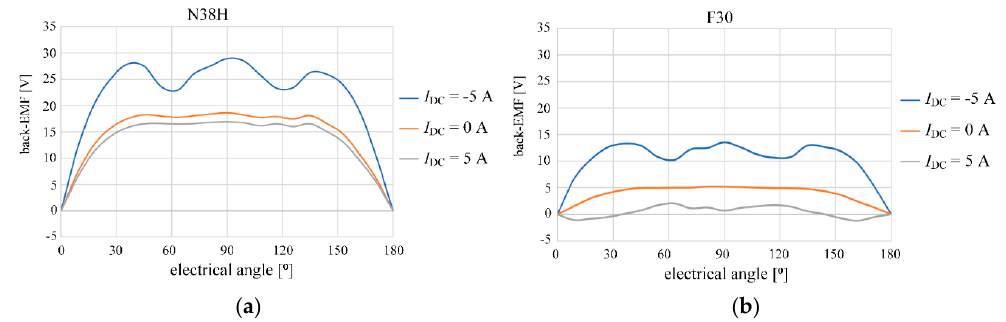
Figure 15. Induced voltage waveforms depending on different DC coil currents for: ( a ) N38H and ( b ) F30 PM types [55].